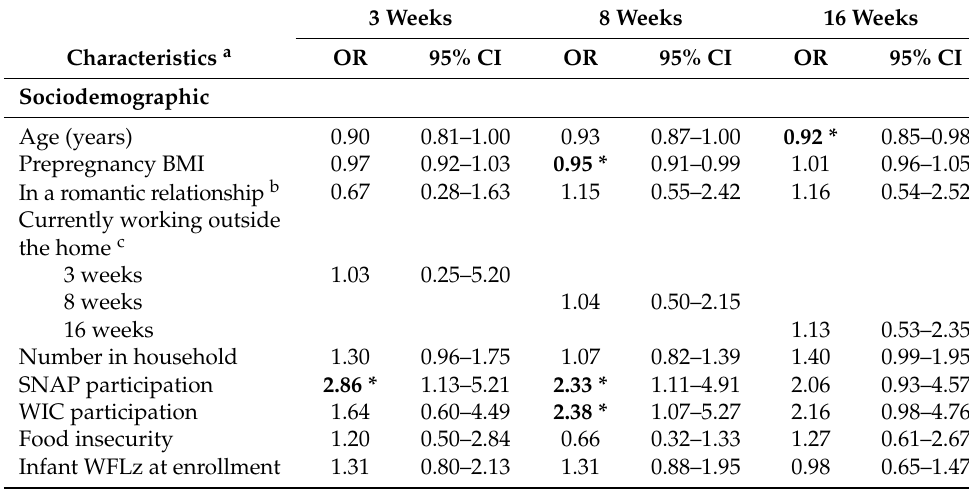
Table 3. Bivariate logistic regression models for associations between select sociodemographic and psychosocial characteristics and cessation of any breast milk feeding at infant ages 3, 8, and 16 weeks among African American mothers ( n =